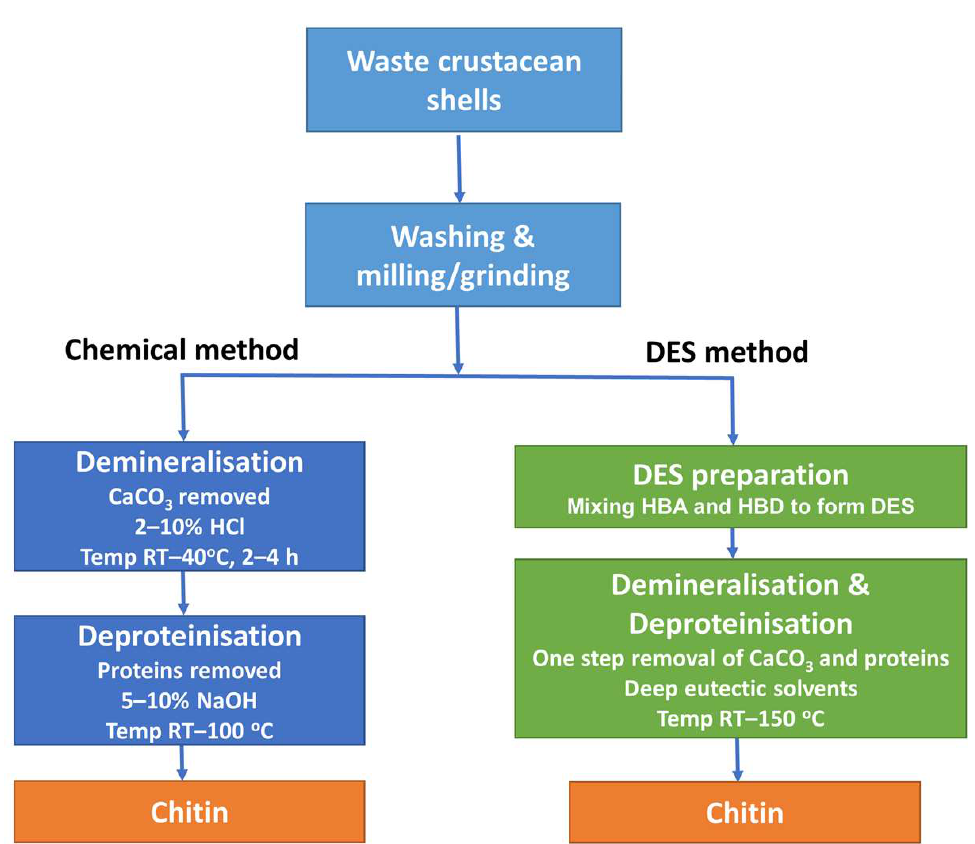
Figure 1. Comparison of steps utilised in chemical and DES-mediated extraction procedures to extract chitin from crustacean shells.